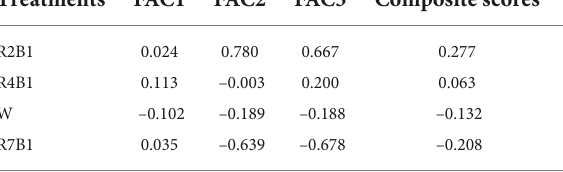
TABLE 2 Factor analysis and comprehensive scores of 4 LEDs light